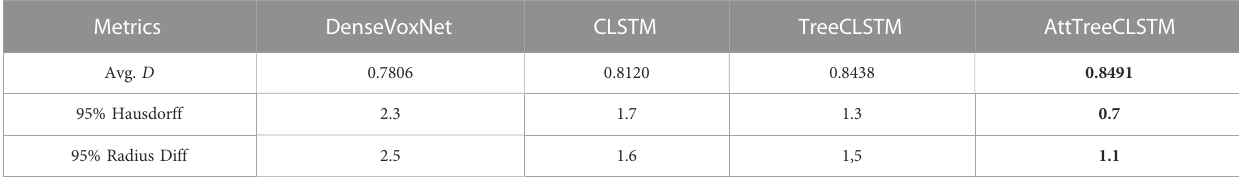
The bold value indicates the best